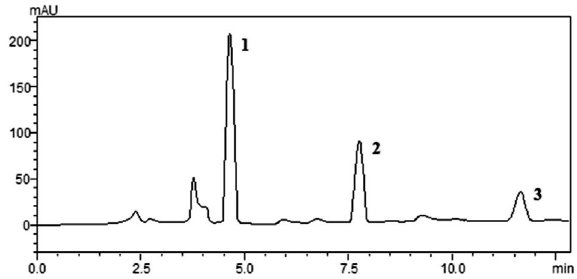
Figure 1 . RP-HPLC chromatogram of the acetylacetone deriva- tives of biogenic amines. Amount of the biogenic amines: (1) his- tamine (15.78 μg L –1 ); (2) tyramine (18.95 μg L –1 ); (3) cadaverine (10.35 μg L –1 ). Mobile phase: acetonitrile-water (35:65%, v/v );